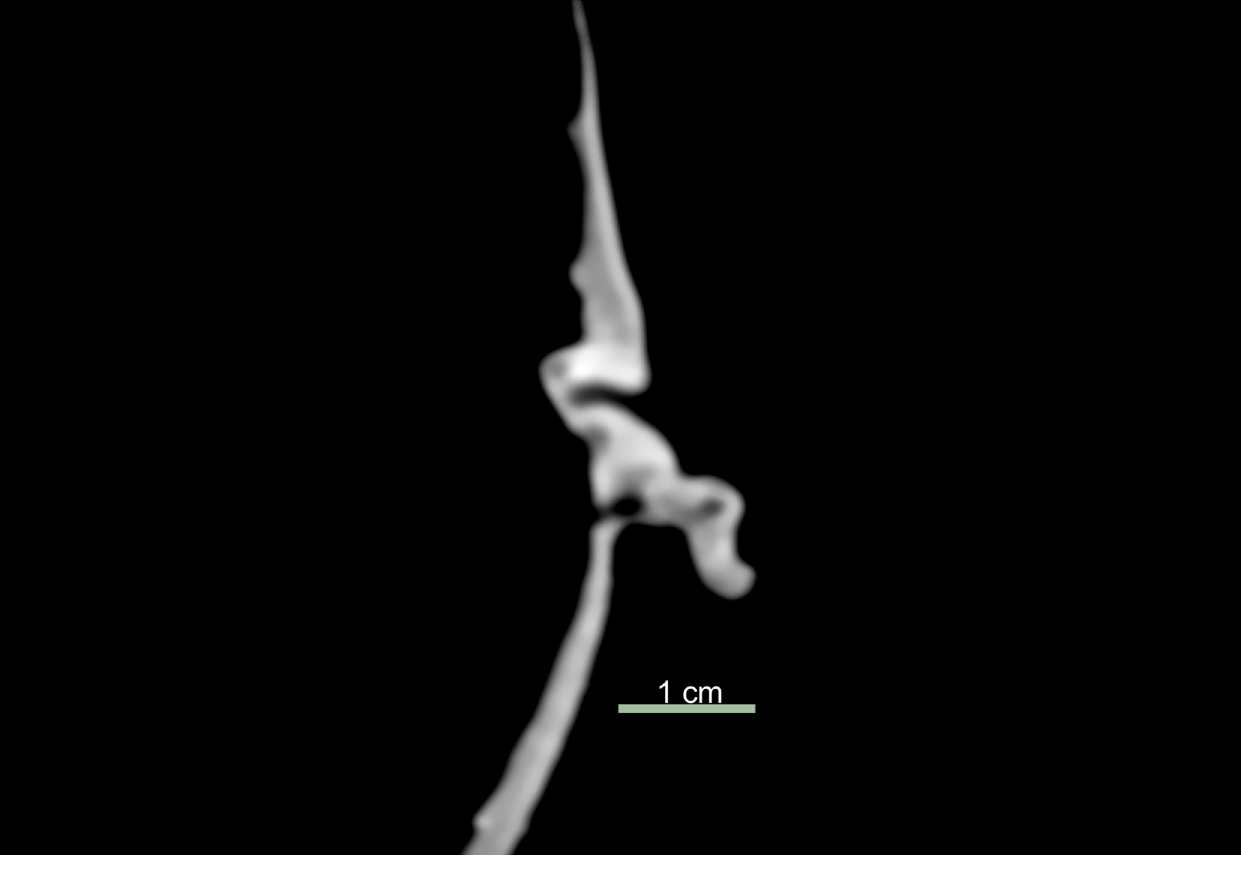
Fig 6. Comparative slice images of the right ear at different resolutions. Clinical CT axial slice of the right auditory canal and pinna.